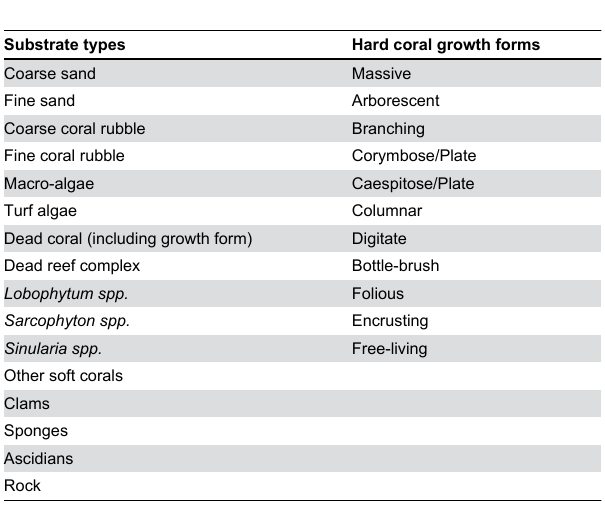
Table 2. Mean and S.E. of the seven environmental